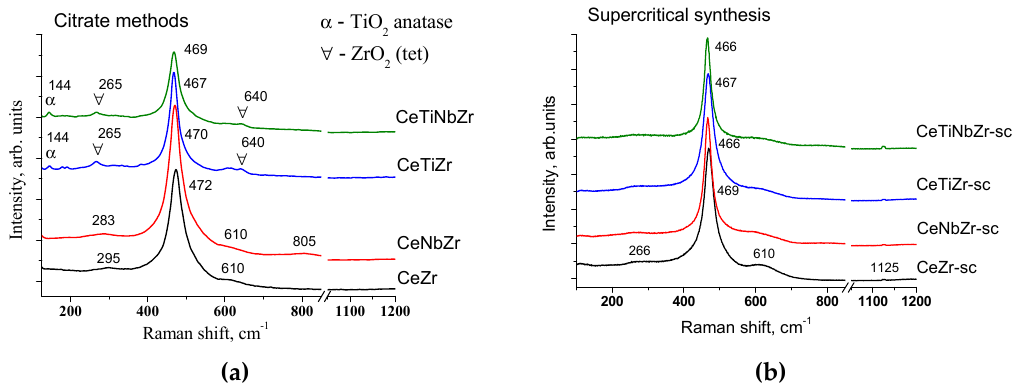
Figure 6. Raman spectra of mixed oxides prepared by citrate methods ( a ) and by supercritical synthesis ( b ).